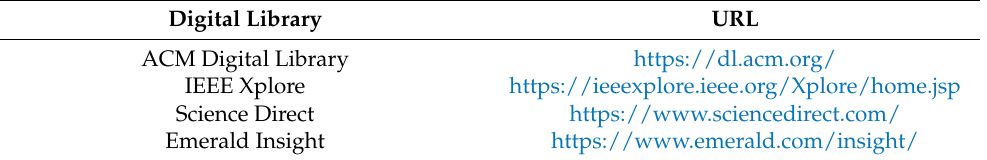
Table 1. Digital libraries used for literature